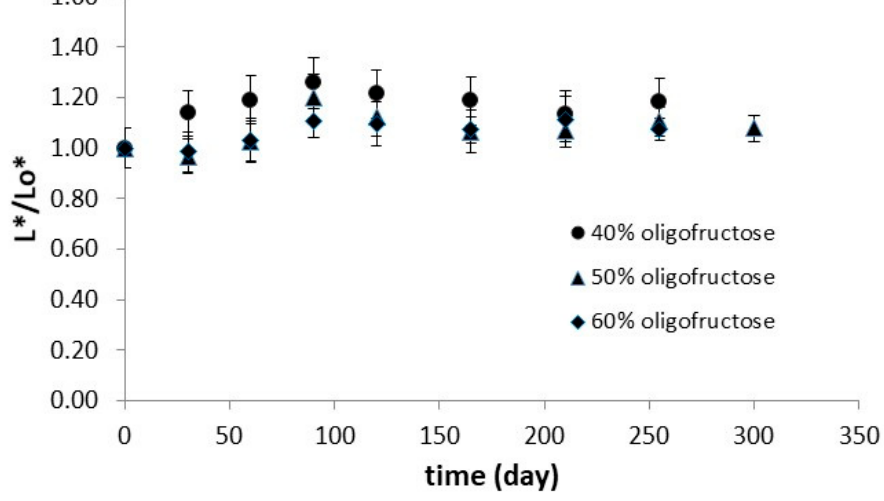
Figure 3. Color change (expressed as L */Lo *) during the osmotic procedure (OT procedure). Error bars represent the ± standard deviation of measurements.